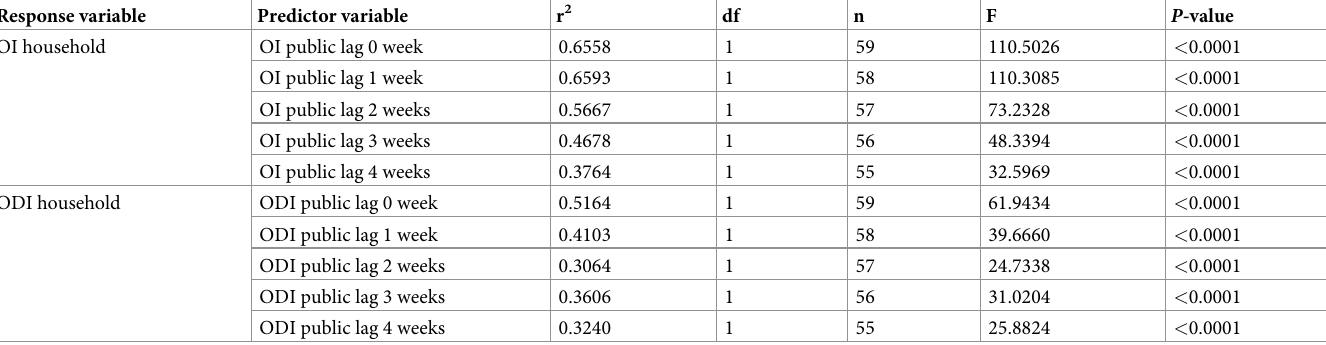
Table 3. Regression analysis of vector indices of weekly household and public places at 0–4-week lag periods. Response